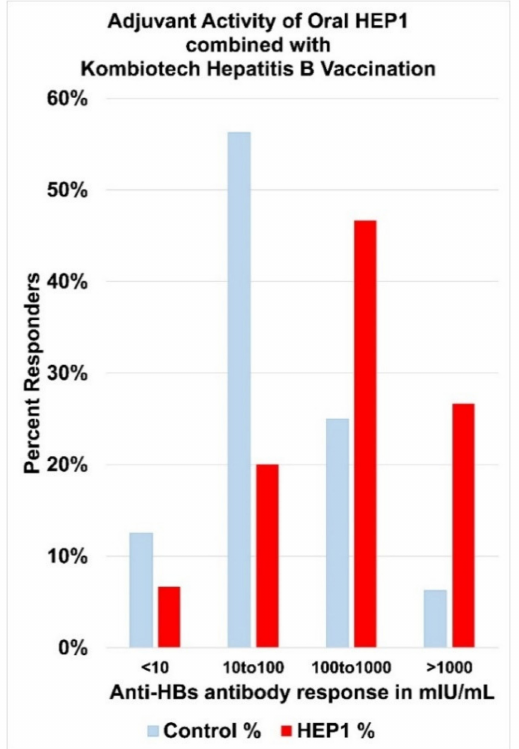
Figure 15. Adjuvant activity of oral 2 mg/2 mL of HEP1 solution given sub-lingually before each of the four Kombiotech hepatitis B Vaccination (KHBV)